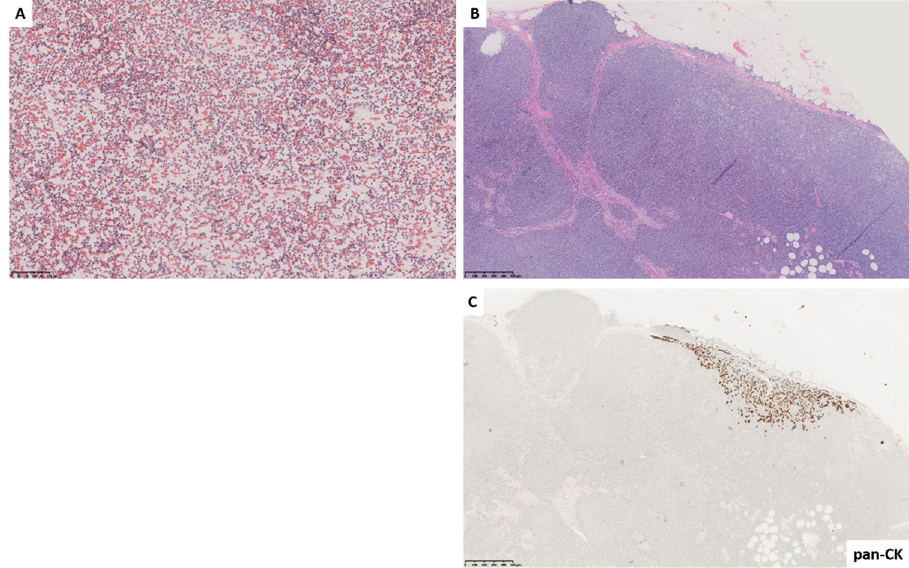
Figure 1. Fine needle cytology smear shows a dispersed polymorphous cell population represented by small lymphocytes and rare medium-sized follicle center cells; no epithelial groups were observed (( A ) Papanicolaou stain). Histological control shows partial, subcapsular involvement of the lymph node by atypical, dischoesive epithelial cells (pan-cytocheratine positive) (( B ) hematoxylin and eosin stain and ( C ) pan-cytokeratin AE1/AE3). Table 3. Correlation between Sydney system diagnostic categories and histology/clinical follow-up. Clinical Follow-Up n o . Histopathologic Correlation n o . Lost n o .